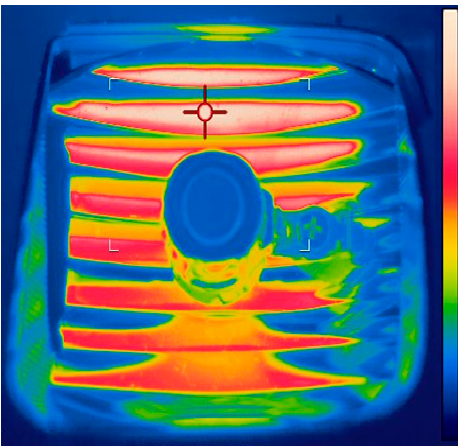
Figure 7. Temperature distribution on reflector surface measured using a thermal imaging camera.